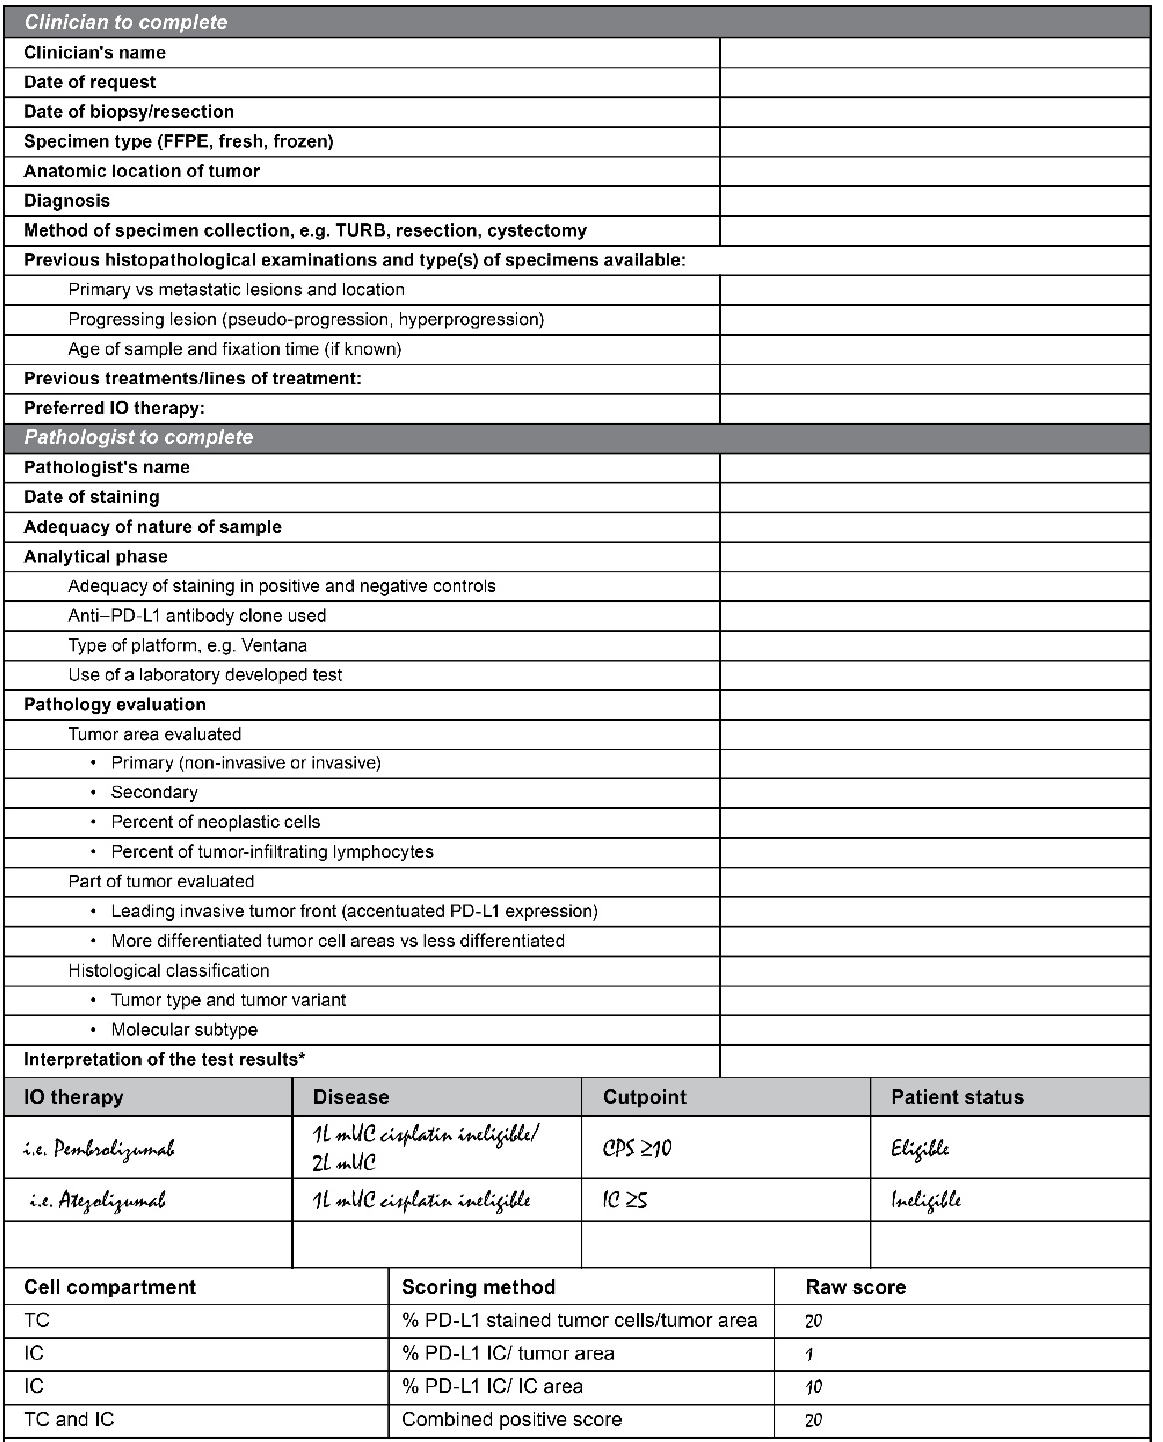
Figure 2. Example of a PD-L1 test request form.